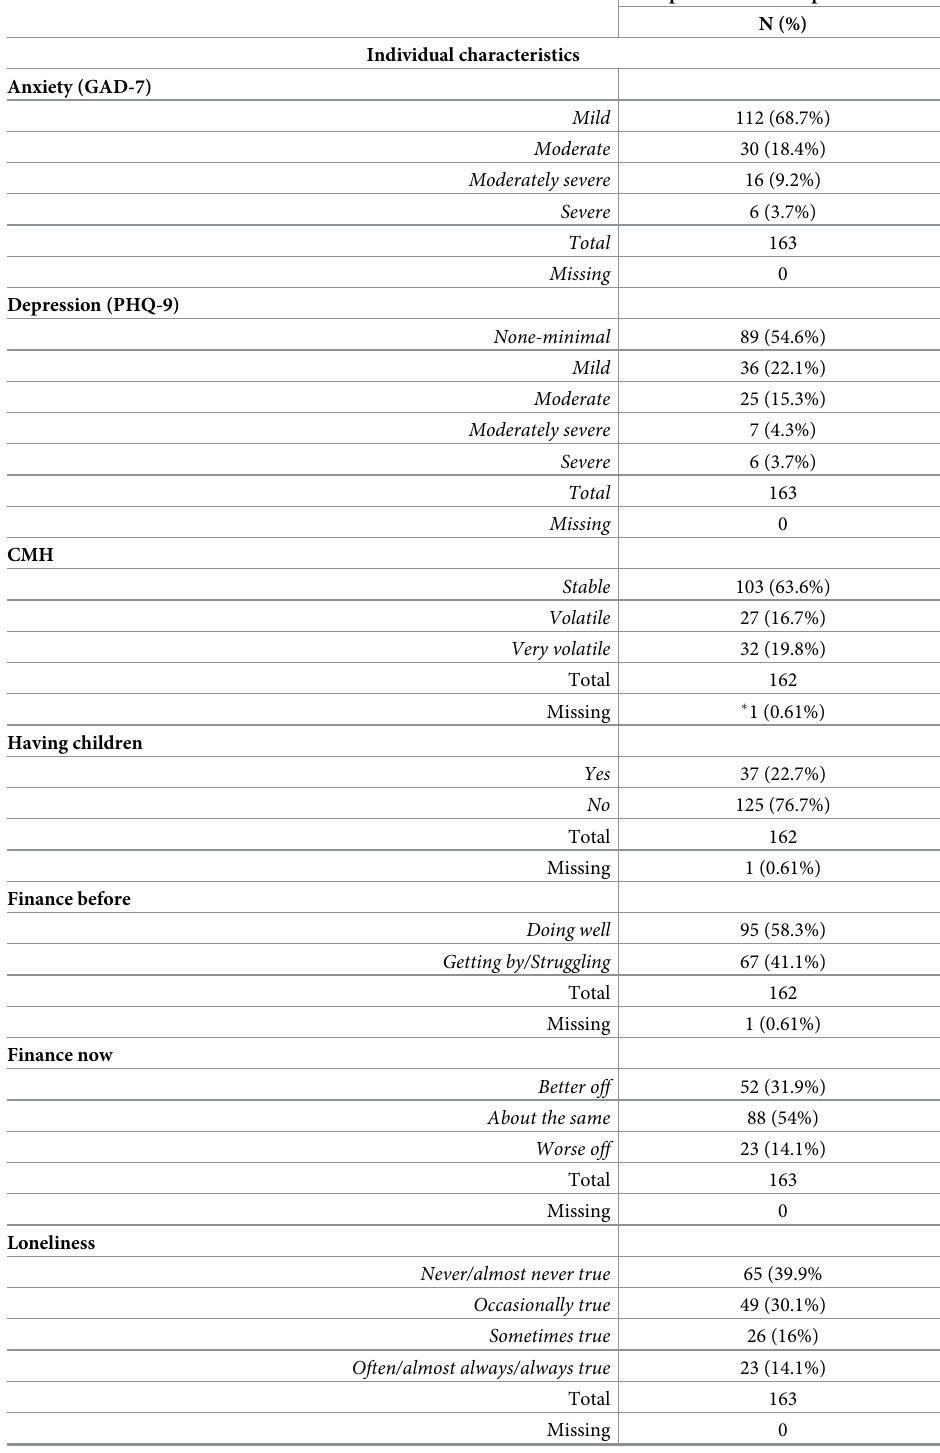
Table 3. Participant characteristics at week 1 (categorical